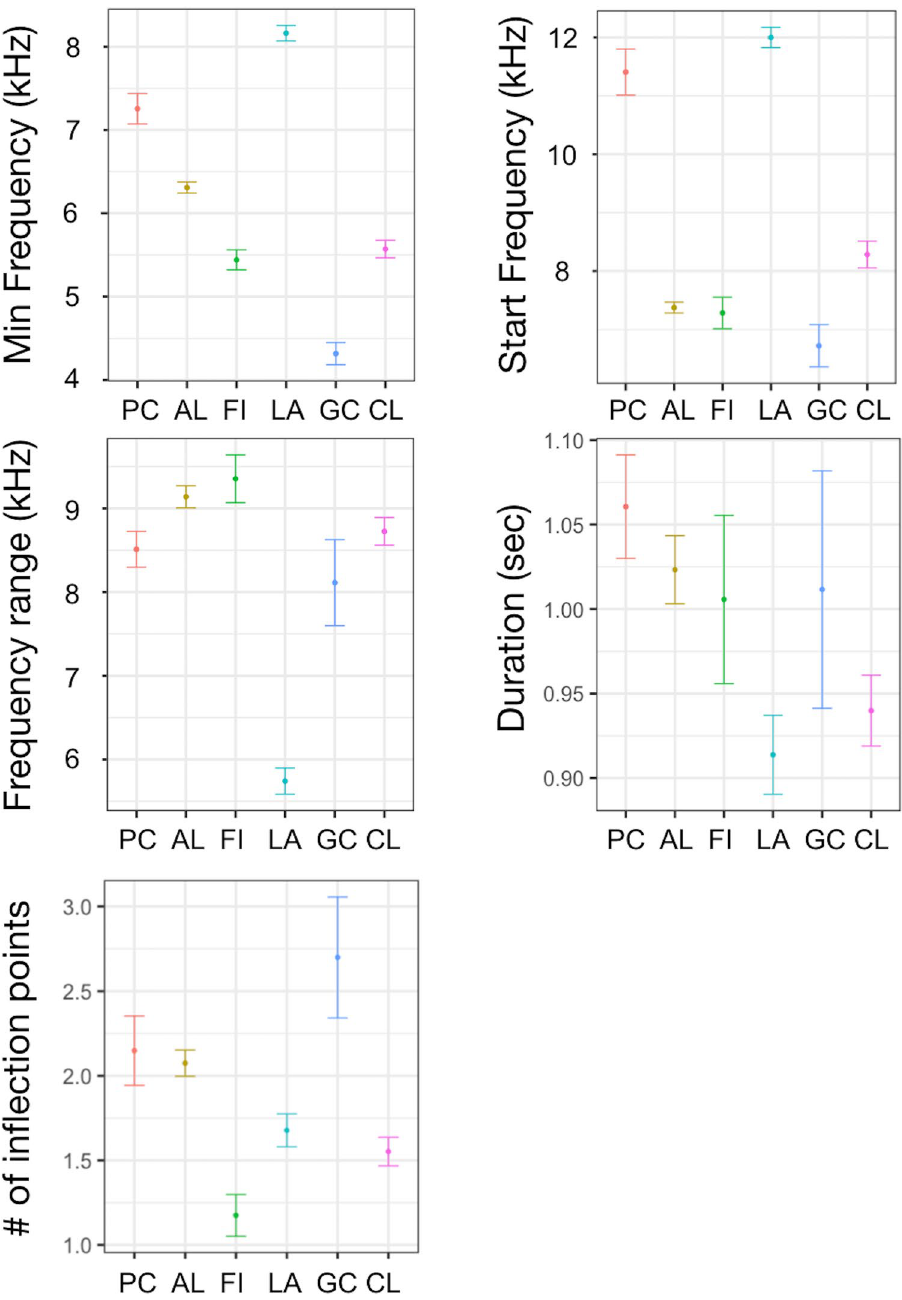
Figure 4. Effect of ‘site’ on ( a ) min and start frequencies (PC2) and ( b ) frequency range, duration and number of inflection points